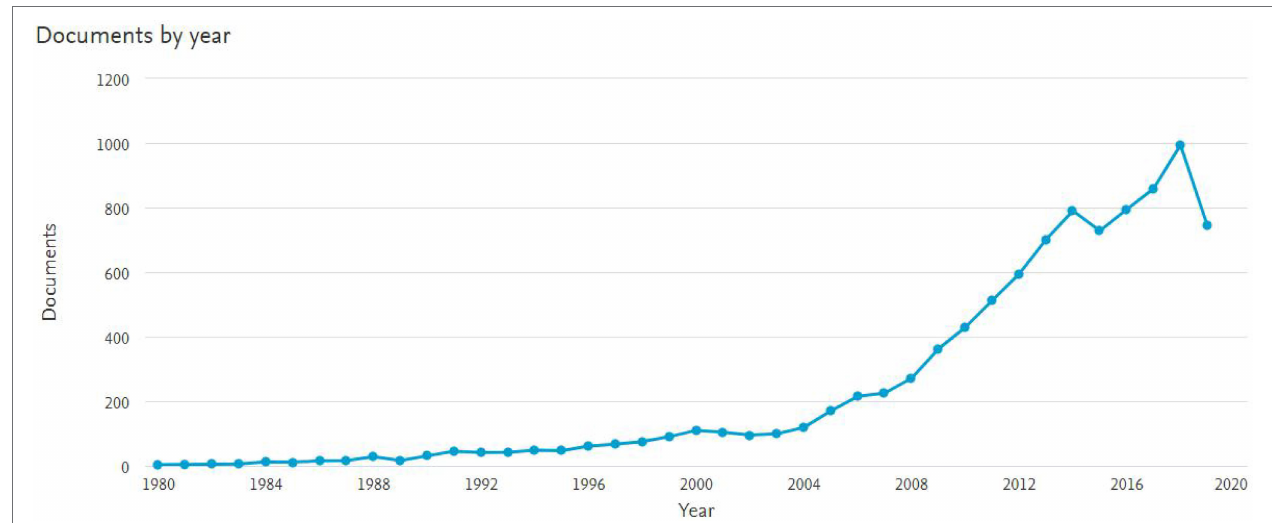
FIGURE 1 | Total publications per year in the field of Scientific Literacybetween the year 1980 to